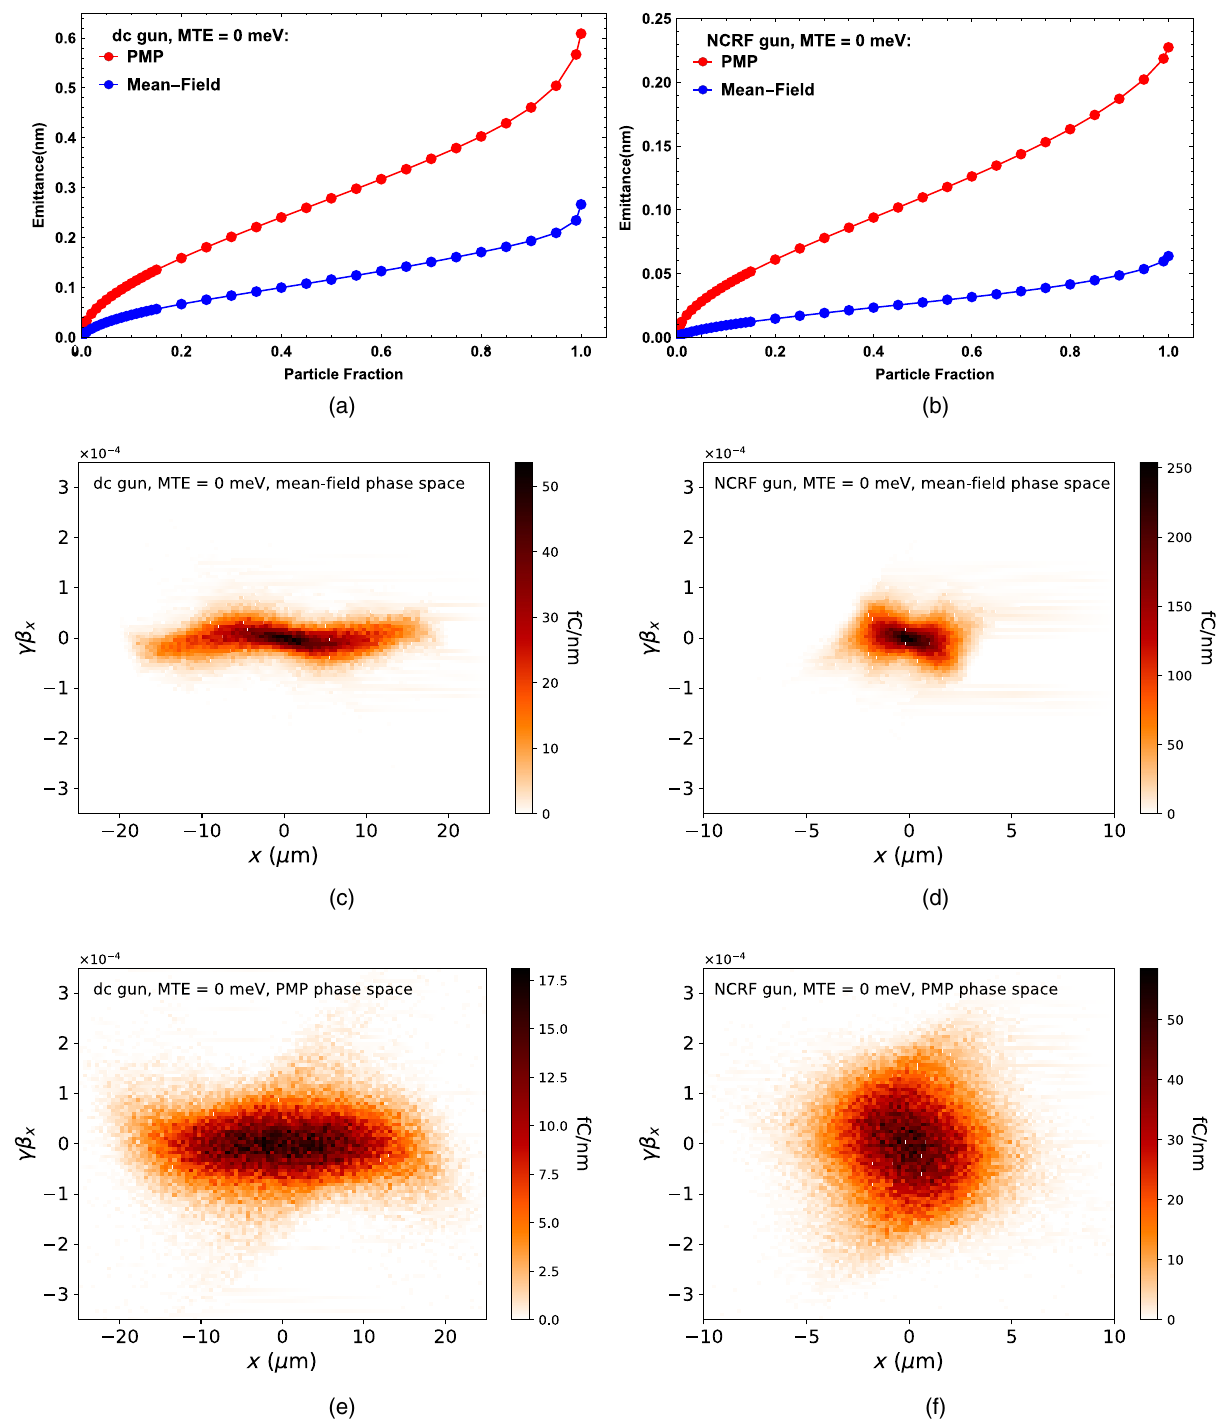
FIG. 7. Transverse normalized rms emittance vs particle fraction plots and phase space comparison between PMP and mean-field simulations of the two UED beam lines at the respective emittance minimum near the end of the beam lines. Subfigures (a), (c), and (e) correspond to the dc beam line and subfigures (b), (d), and (f) correspond to the NCRF beam line. Phase space portraits from the mean-field simulations are shown in subfigures (c) and (d) and for PMP simulations in (e) and (f) phase space portraits are shown with linear x – p correlation x